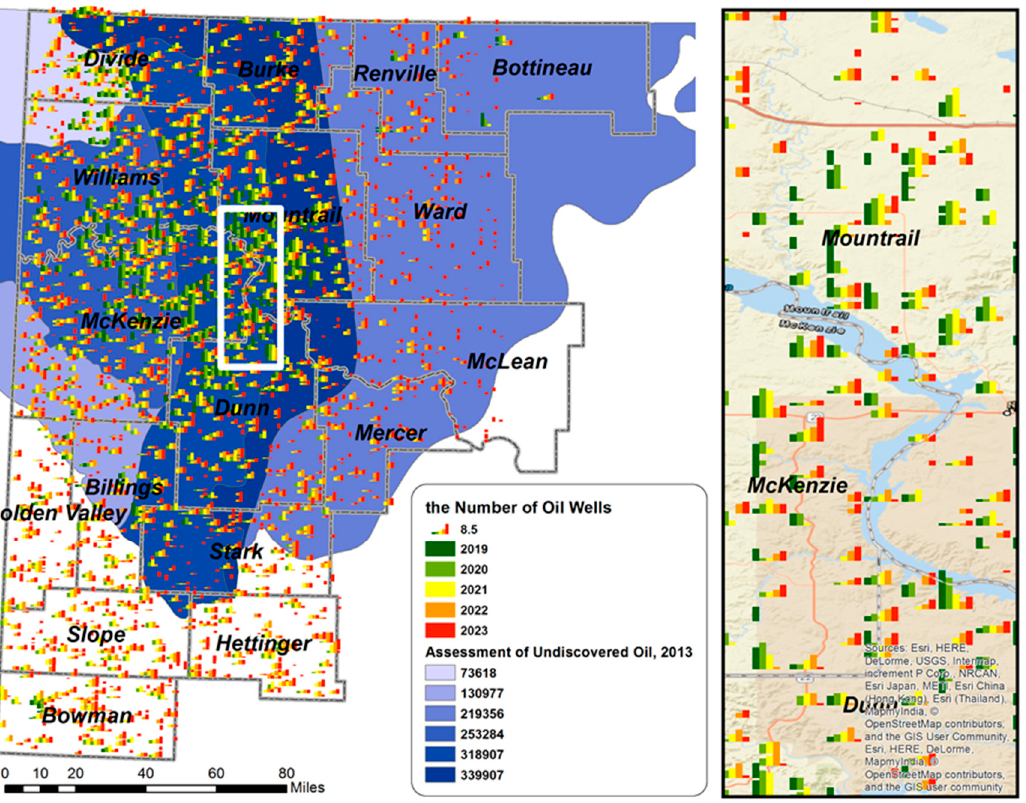
Figure 6. Yearly number of drillings per space.